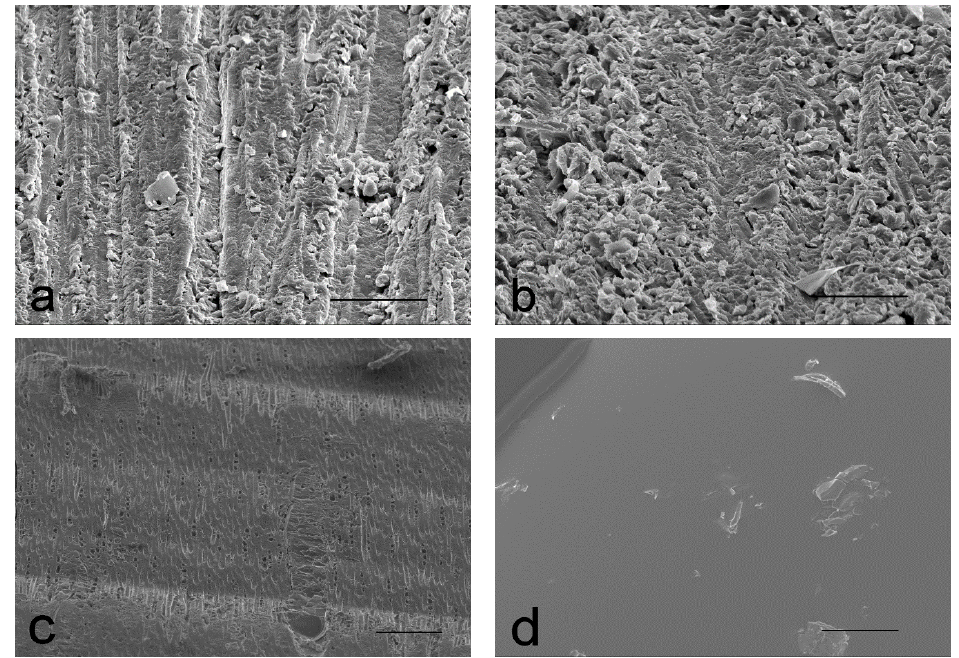
Figure 7. Lignum vitae wood surfaces after: ( a ) sanding; ( b ) sanding/wetting/redrying; ( c ) planing/wetting/ redrying; and ( d ) material removed from ( b ) using transparent tape. Scale bars (a,b) = 50 μ m; (c,d) = 100 μ m.